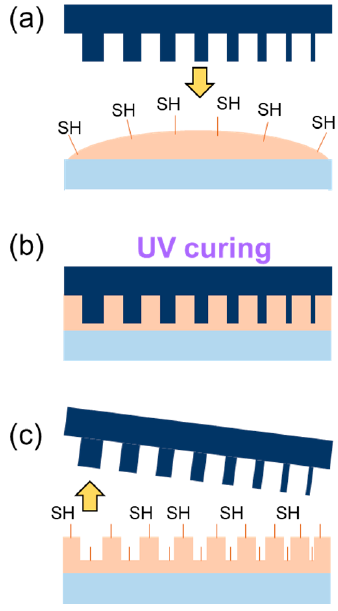
Figure 1. Micro and nanostructuring of the thiol polymer. The polymer (orange) with thiol-groups (-SH) intrinsic to its formulation is drop casted or spin coated on the substrate (blue) ( a ). By bringing in contact with a stamp (dark blue), the polymer fills the structure and is cured with UV light ( b ). After curing, the stamp is released and the polymer surface has the positive structure of the stamp and the functional thiol group ( c ).